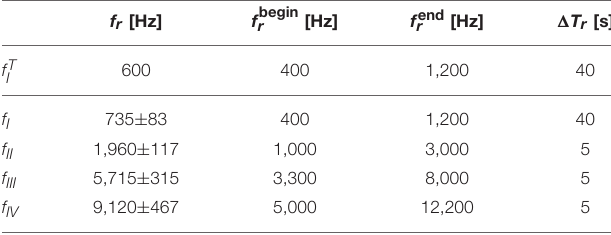
TABLE 2 | Parameters adopted for each frequency range during a linear sweep.